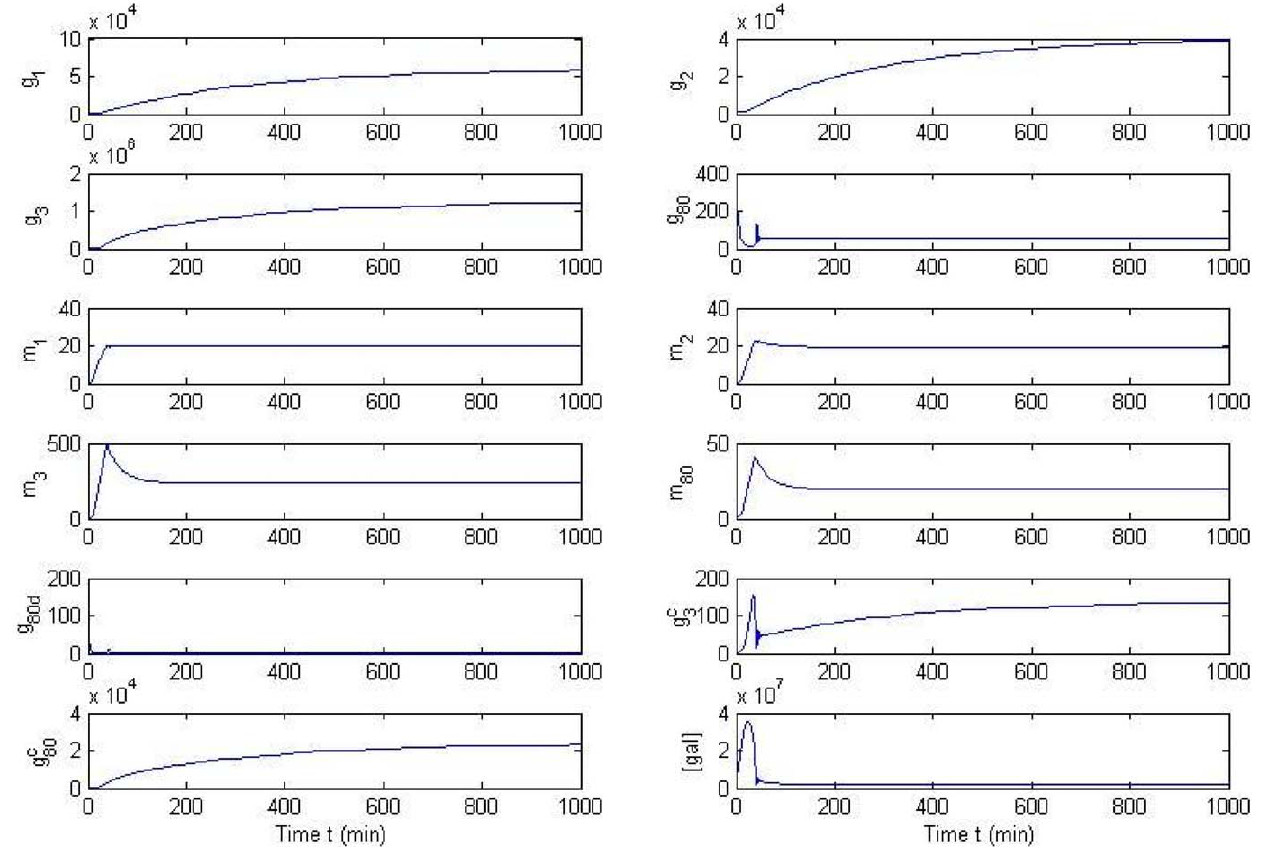
Figure 7. Effect of protein concentration on mRNA expression by feedback control on the GAL network. All states (unit: molec./cell) and g c have slower convergence rates than the other states. The transient process of states g 80 and g c converge to a stable steady state, while g 2 , g c 3 80 is listed in the small windows above. The overshoot of the states is kept in a reasonable range. No severe fluctuations or oscillations are found in the GAL network under feedback control.